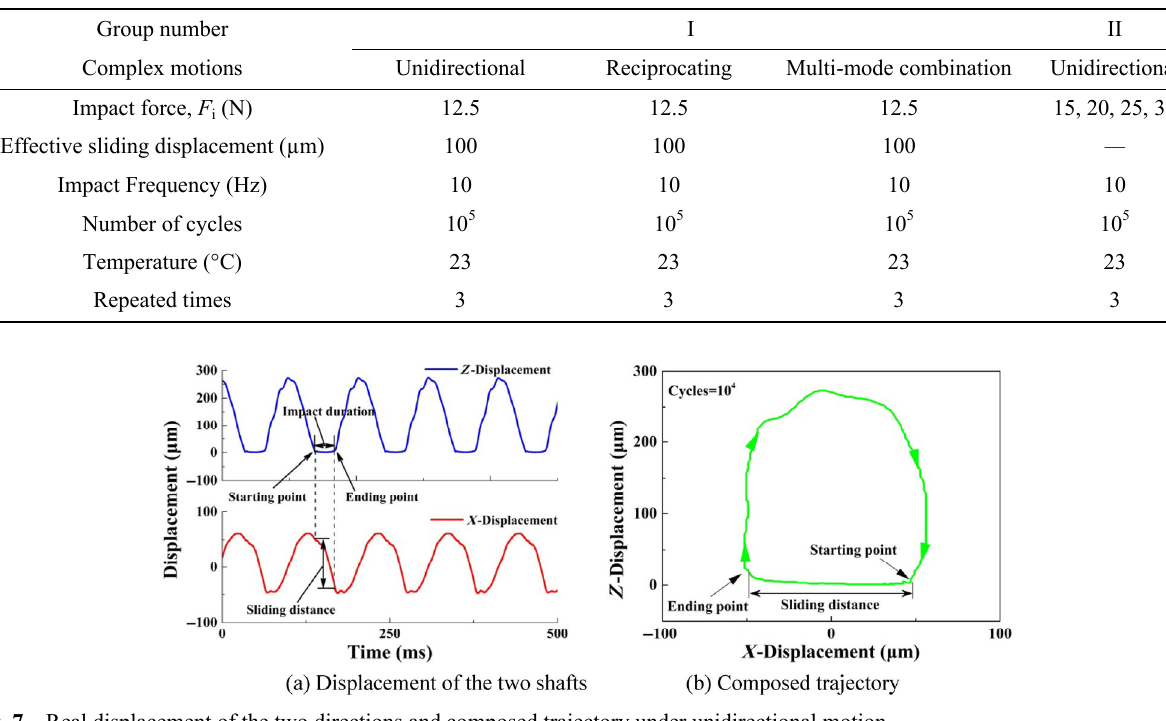
Table 1 Test parameters.